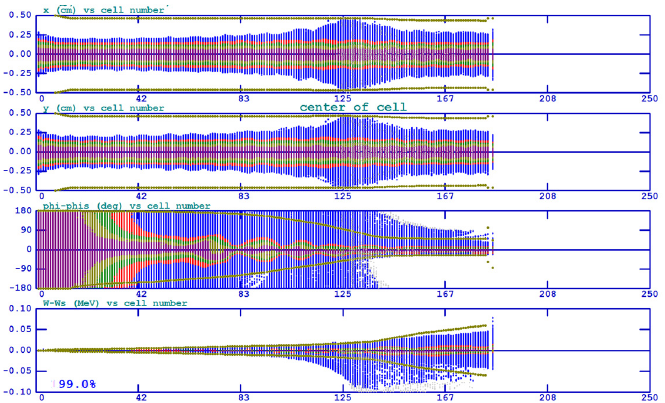
Figure 4. Evolution of beam envelopes along the RFQ cell from PARMTEQM. Plots from top to bottom are the beam profiles in the x and y planes and phase and energy spectrums, respectively.